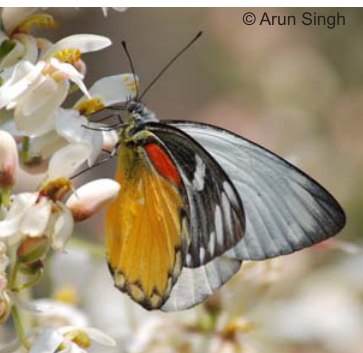
Image 25. Painted Jezebel Delias hyparete